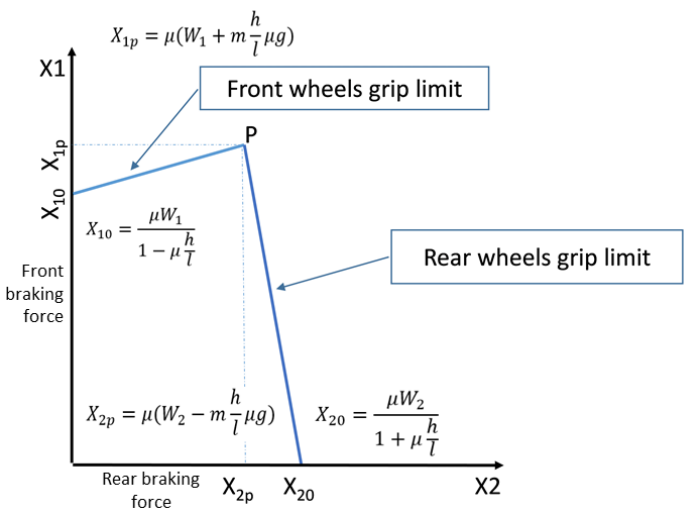
Figure 5. Feasible braking region [30].